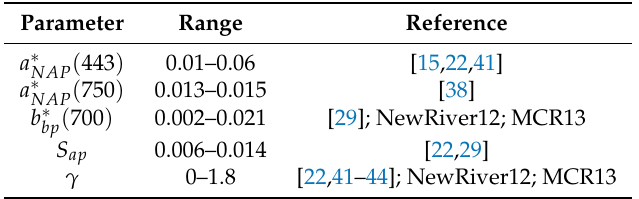
Table 4. Literature Inherent Optical Properties—IOP